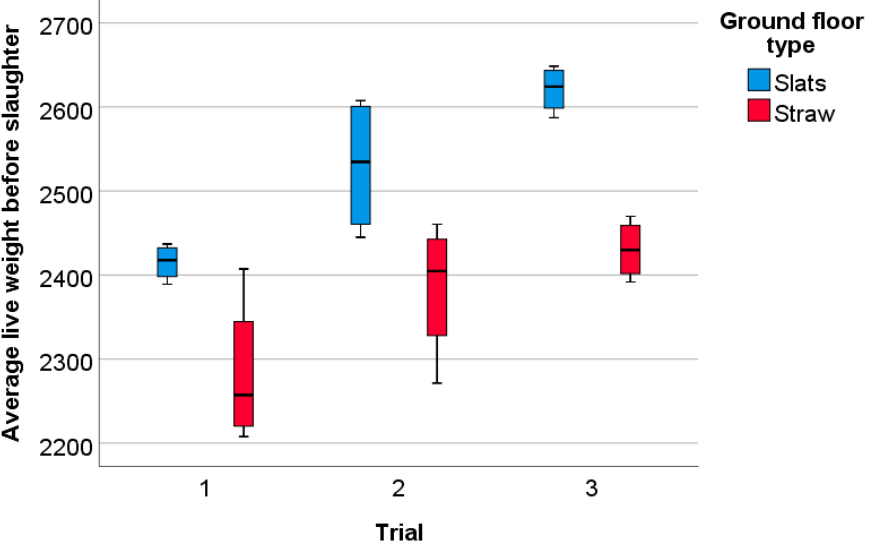
Figure 8. Average live weight (g) shortly before slaughter in g at 82 days of age, according to ground floor type and trial. Slats: pens with ground floor consisting of slatted plastic panels, n = 4 per trial; Straw: pens with the ground floor consisting of concrete littered with straw, n = 4 per trial.